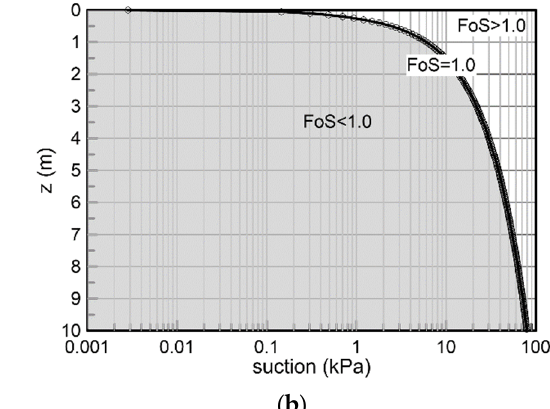
Figure 6. ( a ) Evolution of Factor of Safety (FoS) with suction for different slope heights; ( b ) evolution of FoS with slope height for different suction levels; results from a 2D mechanism (no lateral resistance).